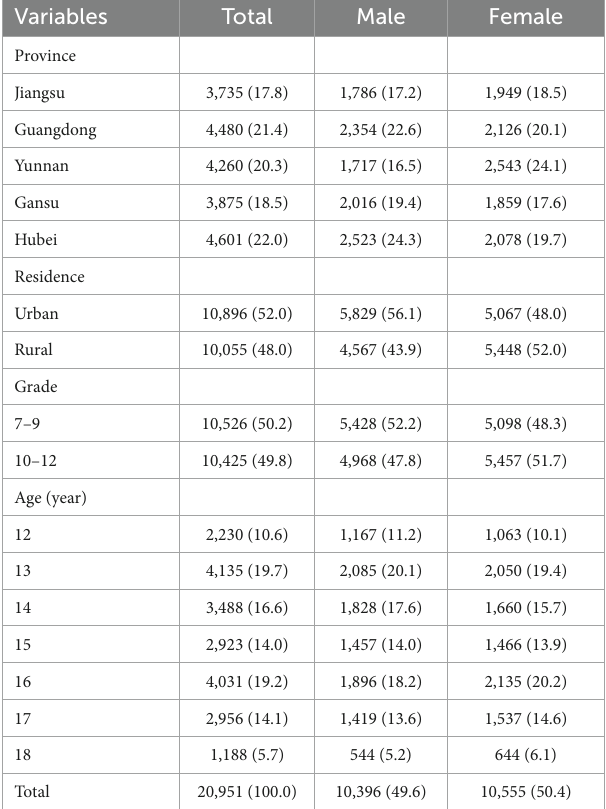
TABLE 1 Demographic information of participants [n